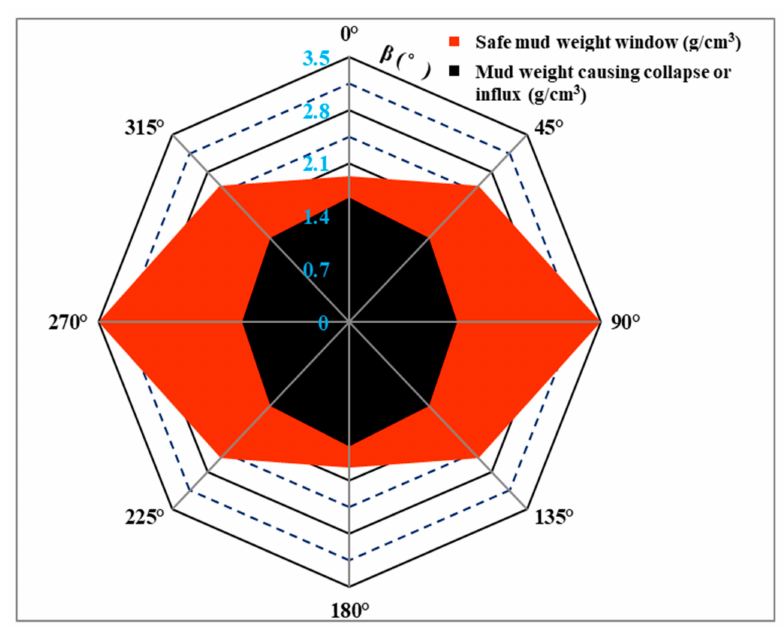
Figure 4. Safe mud weight window of the target zone with ∆ p p / p p = 0.